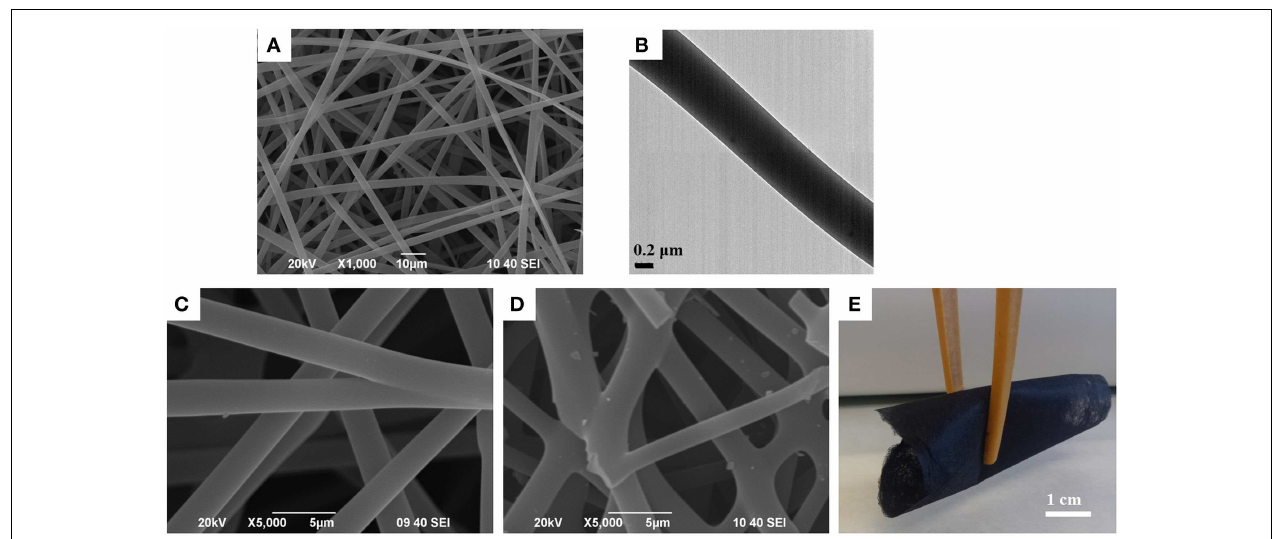
FIGURE 6 | (A) SEM and (B) TEM images of electrospun carbonized lignin fibers; (C,D) SEM images of (C) fragile non-bonded and (D) bonded lignin-based CFs showing the flexibility (E) of the later ones.